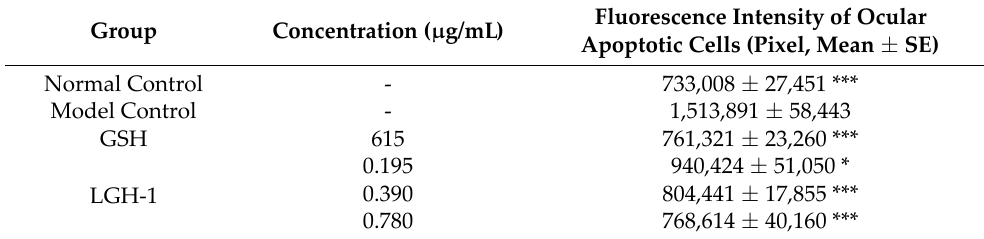
Table 2. Evaluation results of lutein eye protection efficacy ( n = 10).